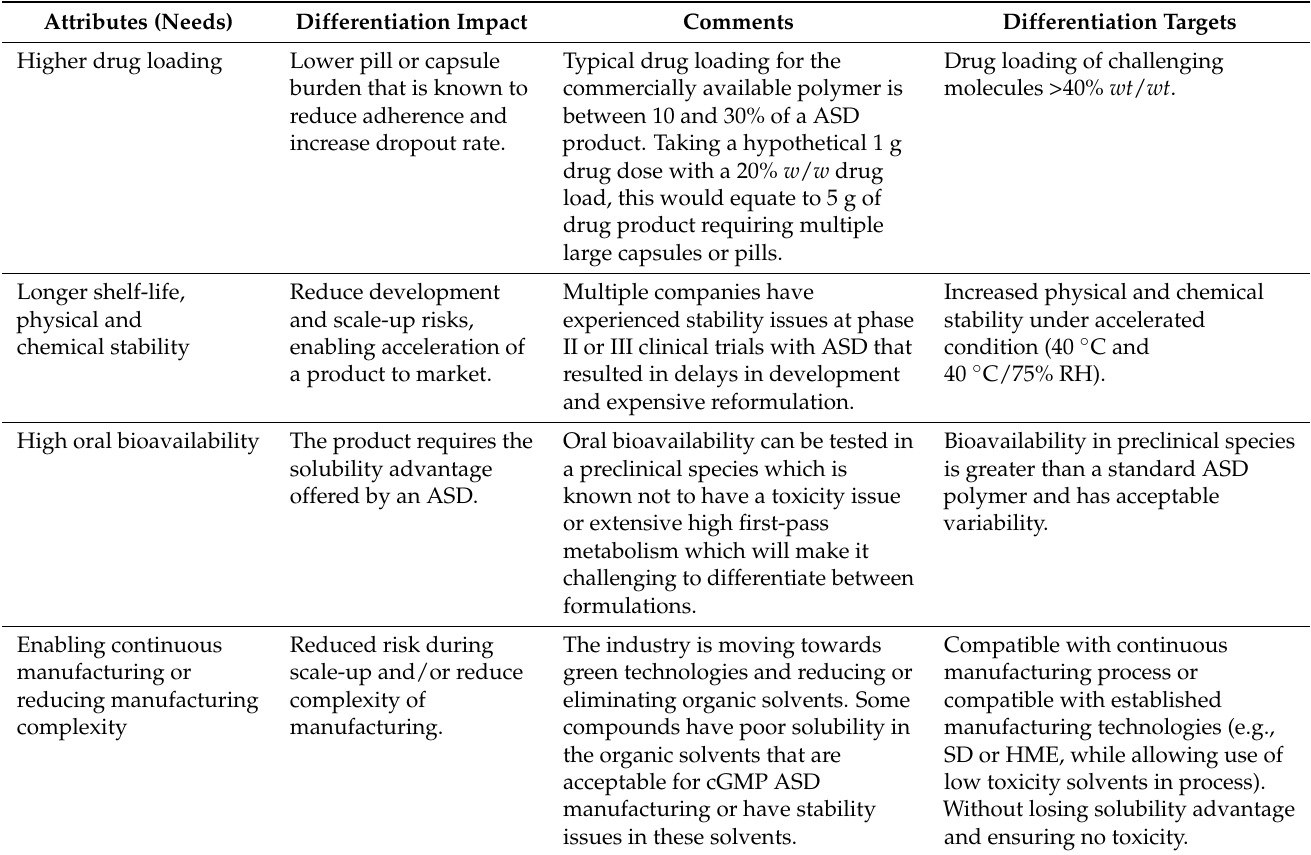
Table 5. Attributes (needs) required for new ASD polymers to show differentiation from currently available commercial polymers. Attributes